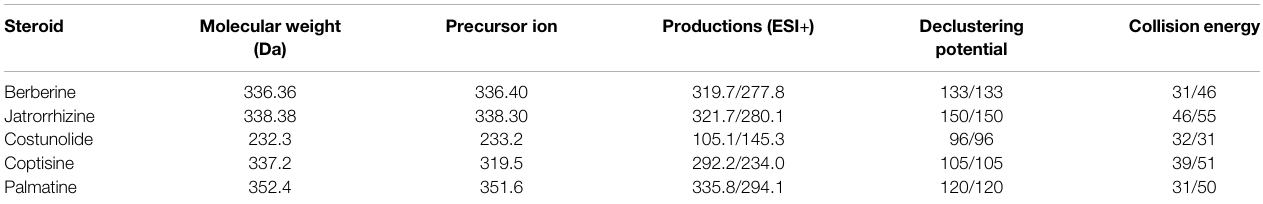
TABLE 3 | LC-MS/MS data for the Xianglian